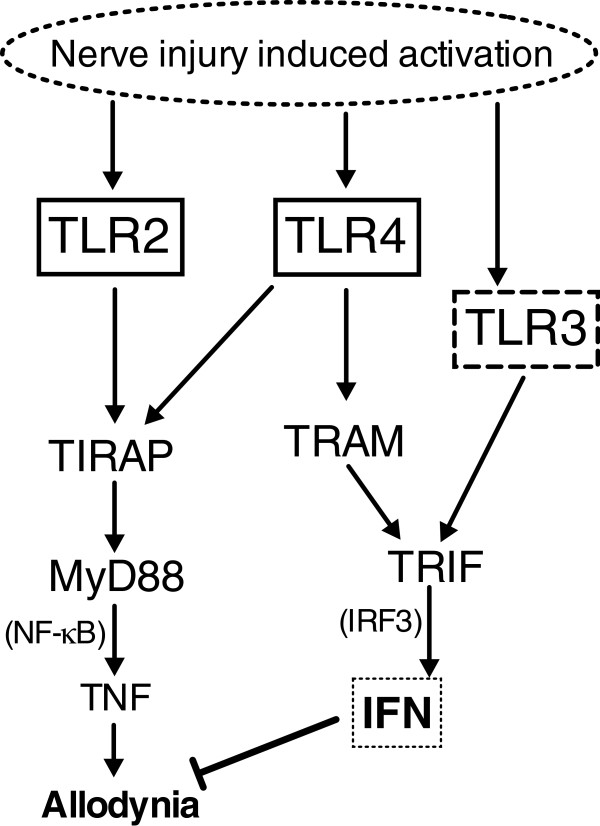
Hypothesis for the development of tactile allodynia following nerve injury. TLR 2 and 4 are expressed on the surface membrane (solid outline), signal through the adapters TIRAP and MyD88 resulting NF-κB activation and proinflammatory cytokine expression such as TNF. Alternatively, TLR4 can signal through adaptors TRAM and TRIF. TLR3 is expressed in the endosome (dotted outline) and signals through TRIF. TRIF can activate IRF3 and initiate IFNβ transcription. We hypothesize that there is an initial endogenous TLR activation signal following nerve injury that results in: i) concurrent activation of multiple TLRs; ii) the TLR2 and TLR4 TIRAP-MyD88 pathway and production of TNF produces an ipsilateral and contralateral tactile allodynia; and iii) the TLR3-TRIF pathway suppresses contralateral allodynia development associated with interferon release (dotted square) and downstream interferon receptor signaling.